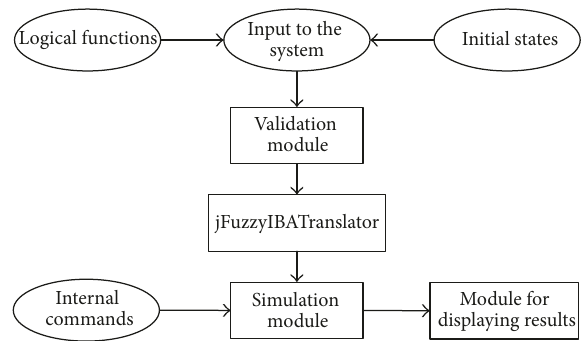
Figure 1: Software support tool